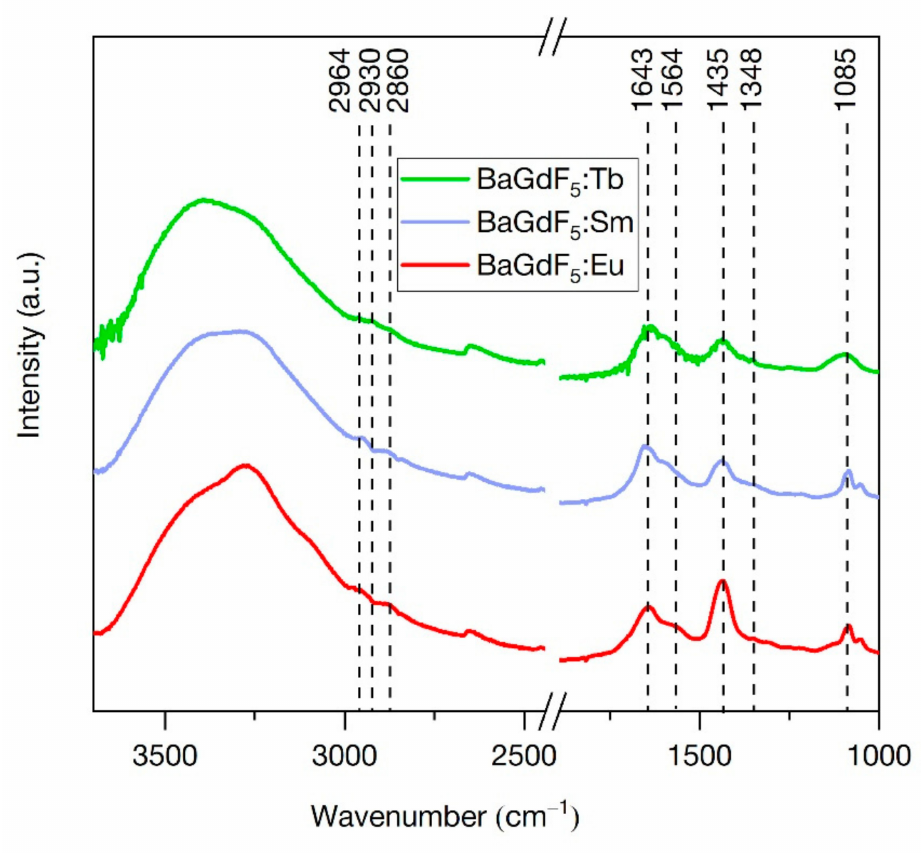
Figure 5. FTIR spectra of the synthesized